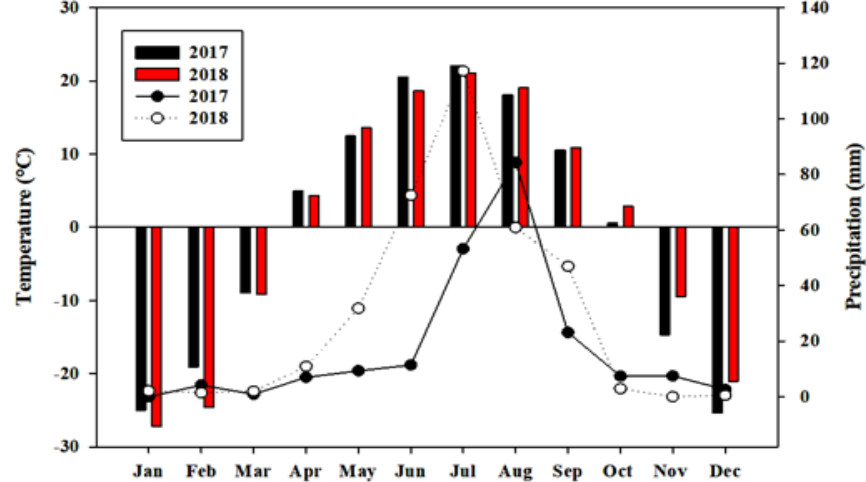
Figure 2. Monthly average temperature and precipitation over selected periods, at the experimental site in the meadow steppe of Hulunber, Inner Mongolia. site in the meadow steppe of Hulunber, Inner Mongolia.